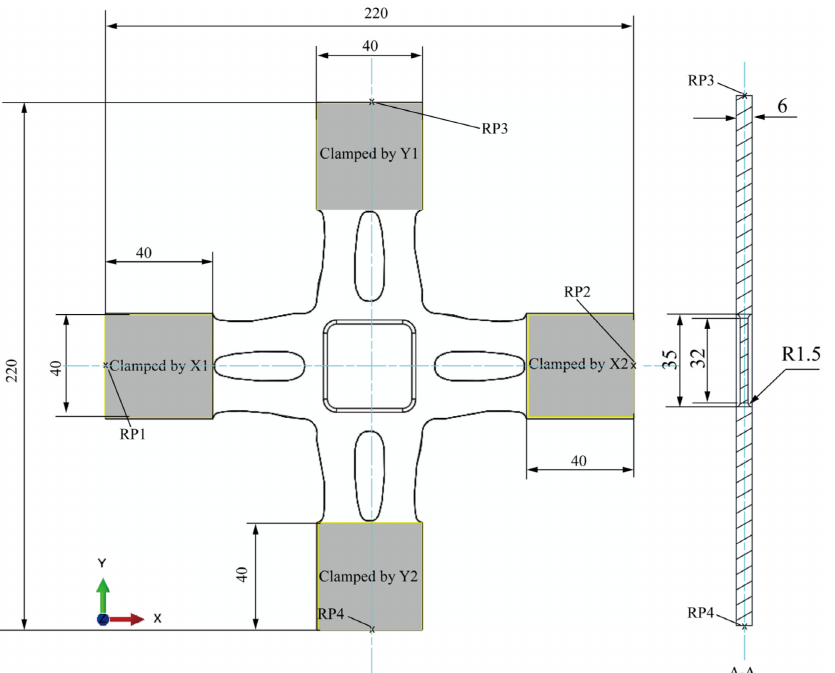
Figure 7. A physical model for shape optimisation.